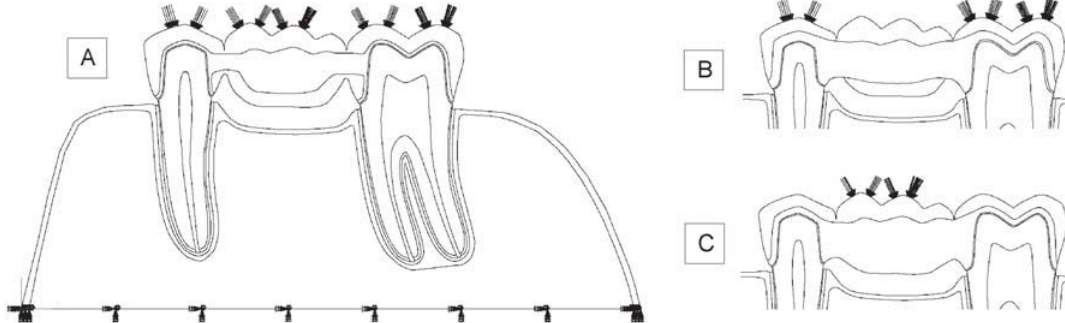
FIGURE 1- (A) Metal-ceramic FPD. The boundary conditions used for all models and the load applied distributed on all teeth (physiological load); (B) All-ceramic-OC FPD. Load applied only on abutment teeth and (C) All-ceramic-O FPD. Load applied only on the